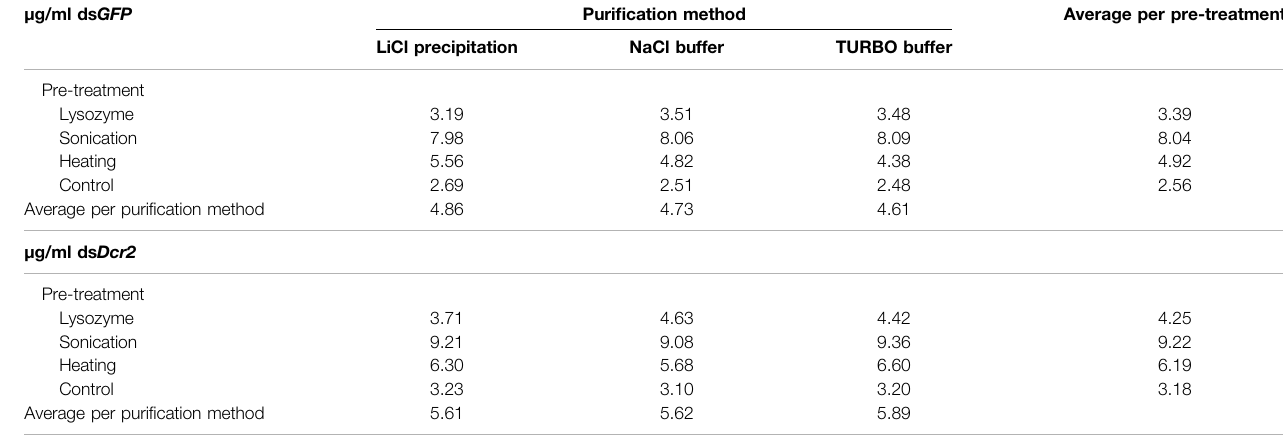
TABLE 2 | dsRNA production yield (µg ds GFP or ds Dcr2 per ml bacterial culture) for all combinations of pre-treatments and puri fi cation methods tested.